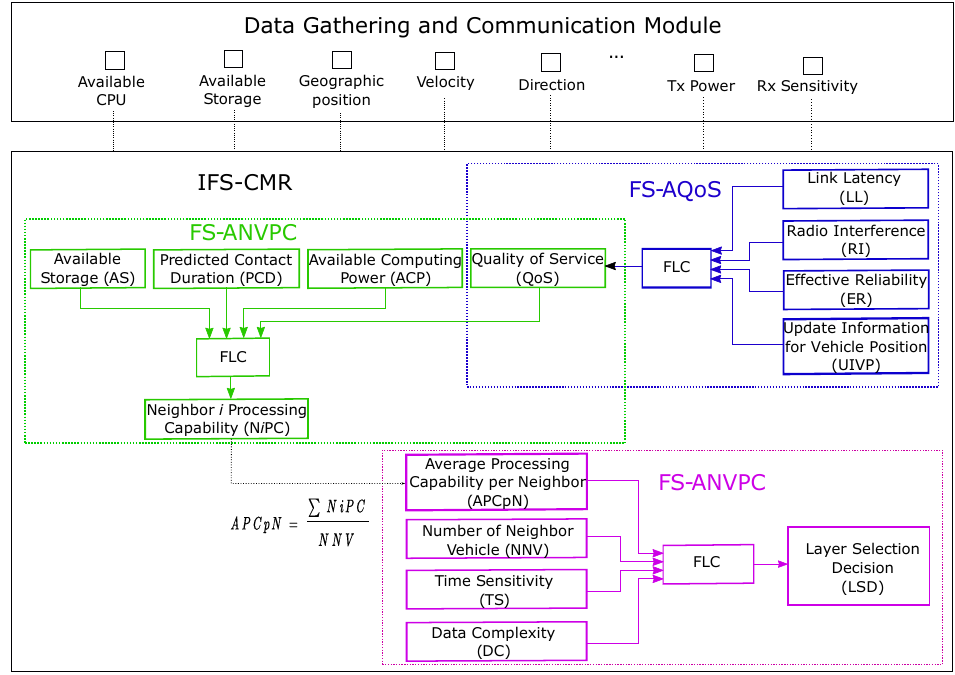
Figure 3. Structure of fuzzy integrated